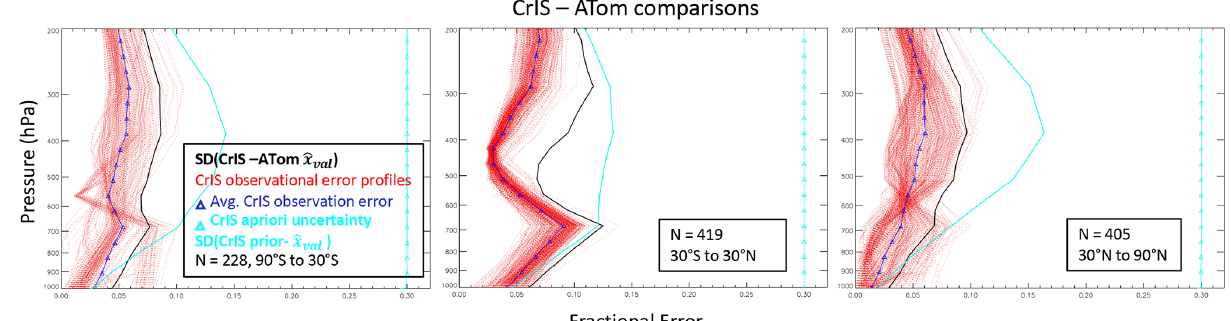
Figure 12. Same as Fig. 11 but for three ATom latitude